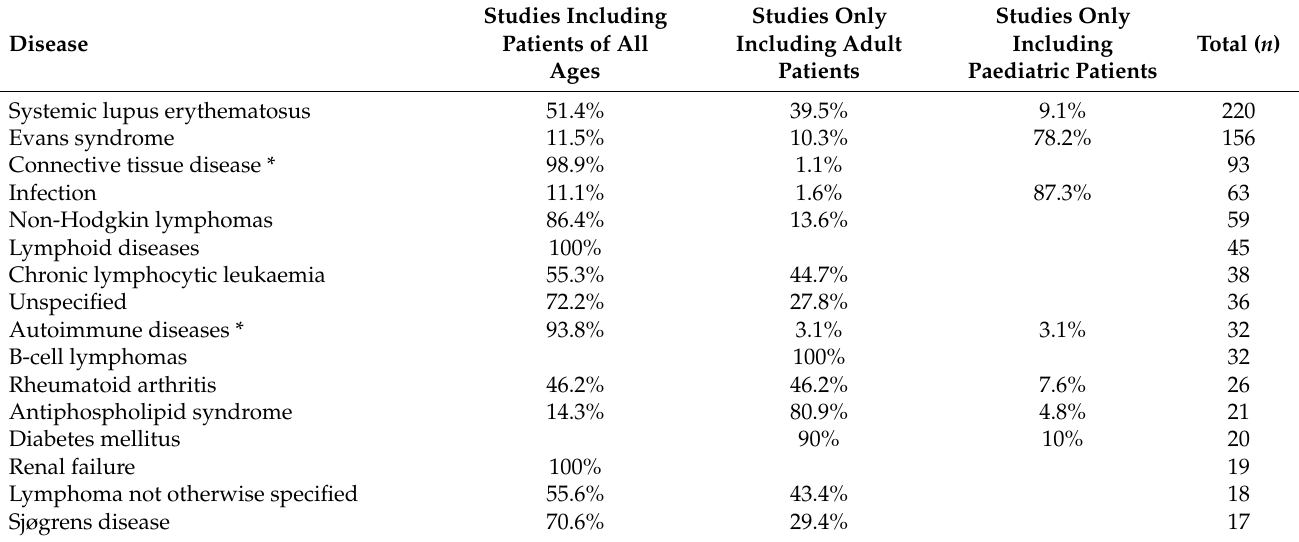
Table 3. The 15 most frequently associated diseases for secondary warm type autoimmune haemolytic anaemia (wAIHA) divided into groups according to age of patients, and the total mentioned in all studies included either only paediatric patients, adult patients or all